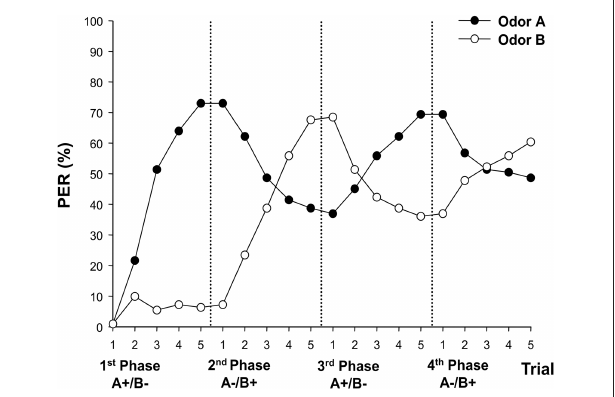
Figure 1 | Conditioned responses during multiple reversal learning in honeybees. Proboscis extension responses (% PER) to odors A and B during four consecutive differential conditioning phases. Bees experienced two contingency inversions between phases: A + → A- and B- → B + from the first to the second phase, A- → A + and B + → B- from the second to the third phase, and A + → A- and B- → B + from the third to the fourth phase. n = 111 bees.